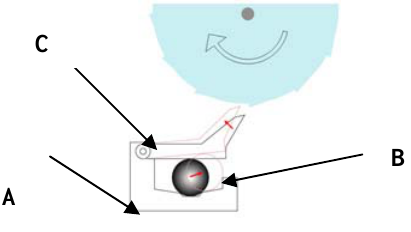
Figure 2. Schematic of a CG type emergency